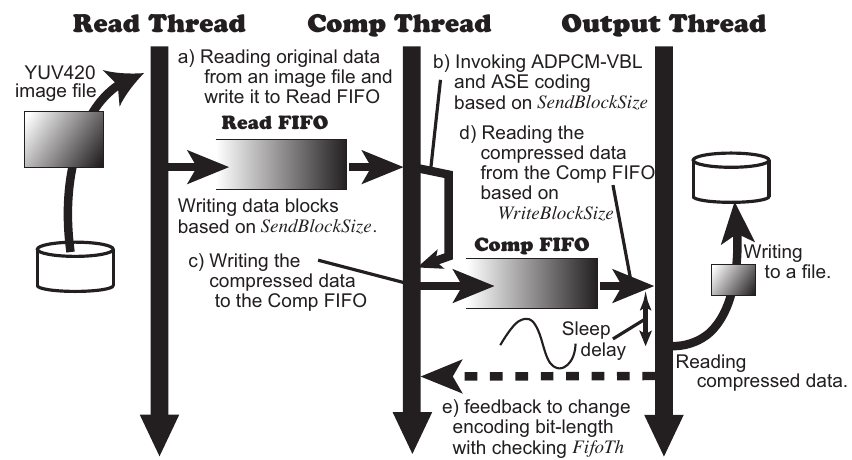
Figure 9. The organization and the data flow of the